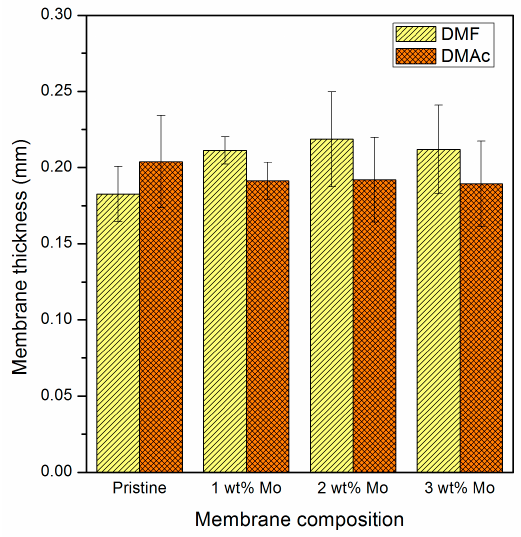
Figure 4. Average membrane thicknesses based on different materials composition.